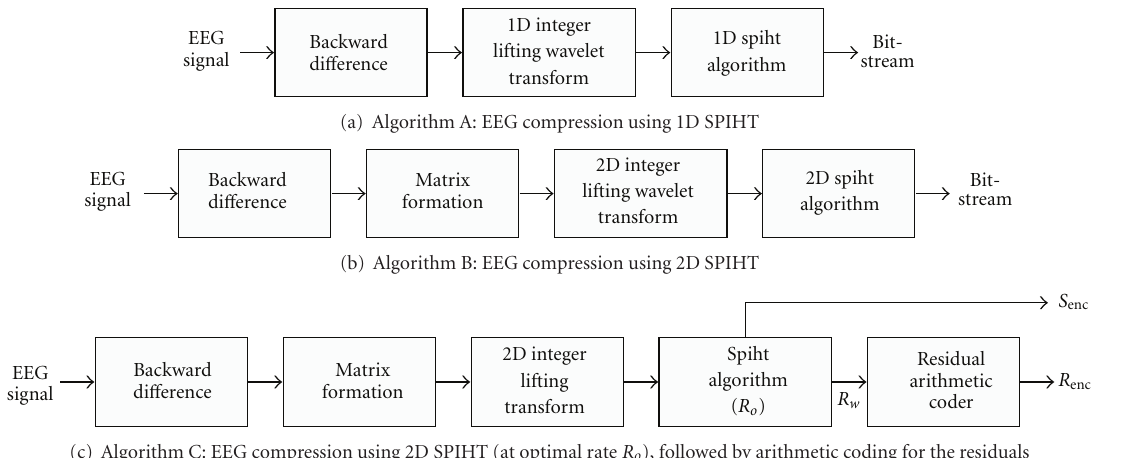
Figure 2: Lossless EEG compression algorithms apply wavelet transforms followed by Set Partitioning in Hierarchical Trees (SPIHT).